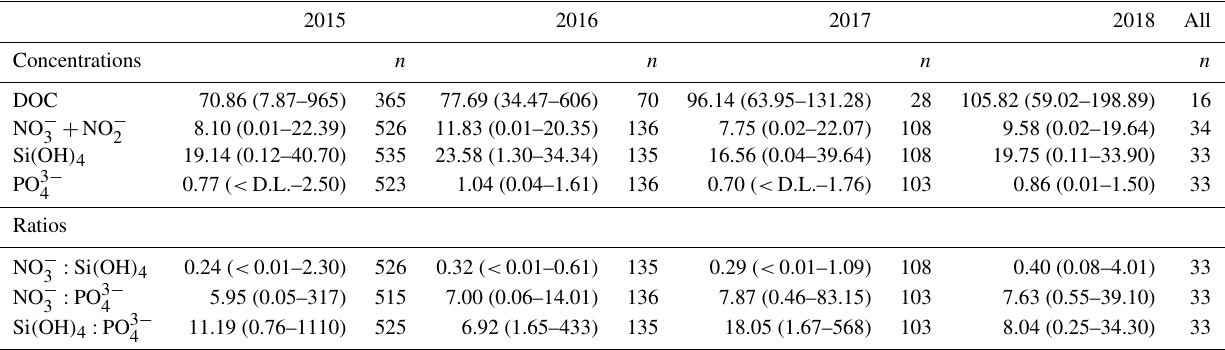
Table 2. Mean (range) annual nutrient concentrations (in µmolL − 1 ) and stoichiometric ratios (molmol − 1 ) across the 13 marine stations in the Meay and Kwakshua